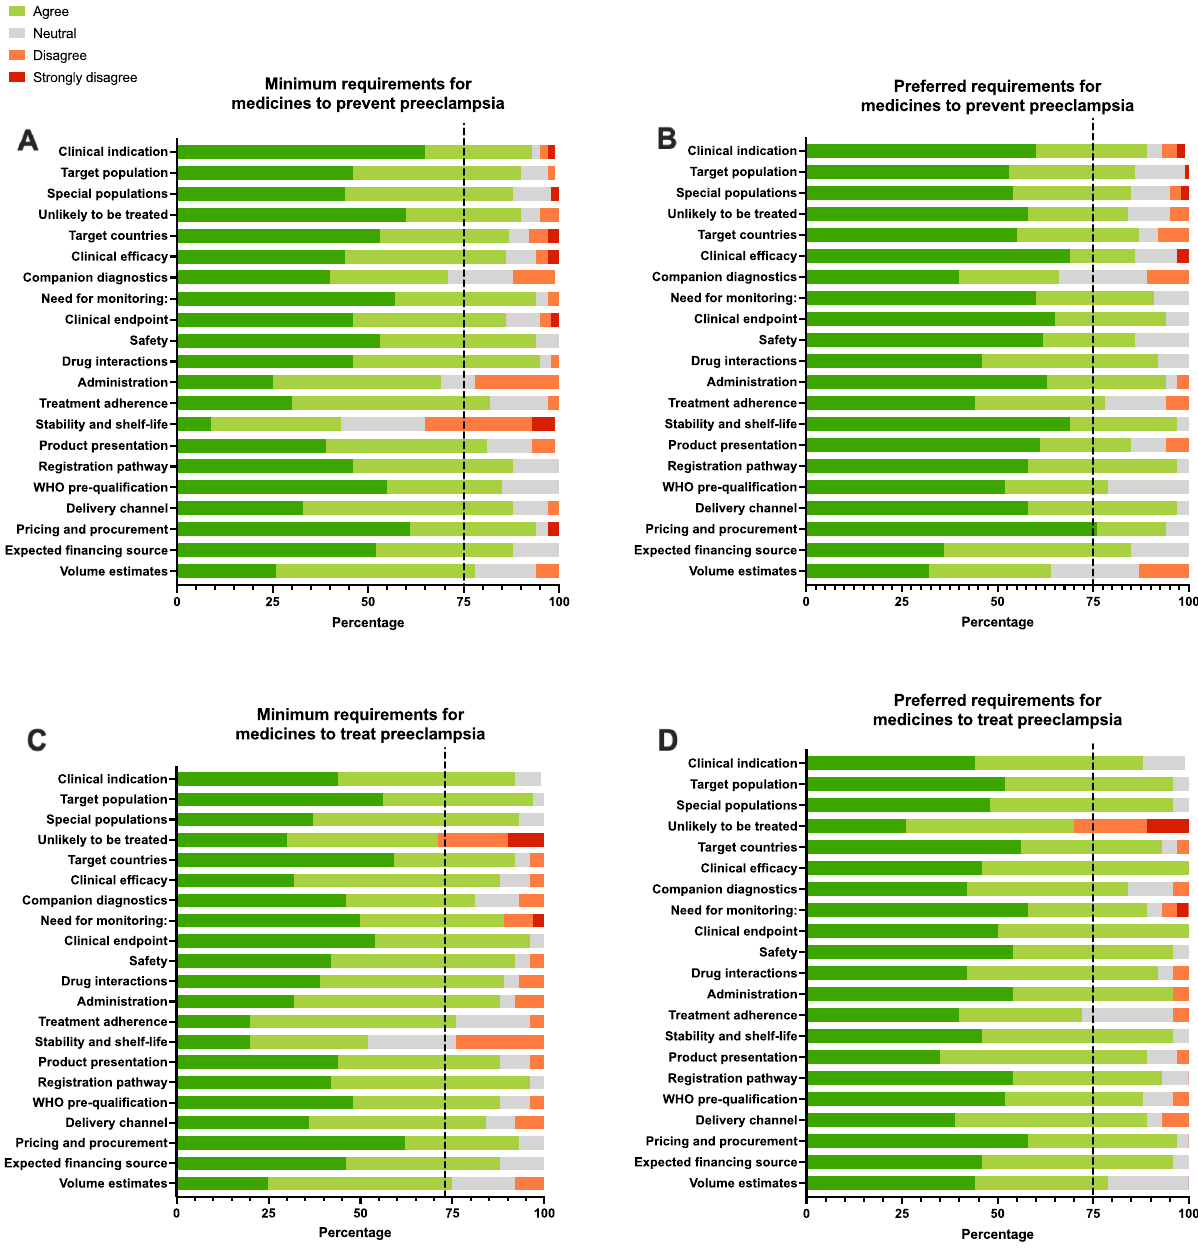
Fig 2. Survey responses. Results from international stakeholder survey (n = 46). Percentage of respondents that strongly agreed (dark green), agreed (light green), were neutral (grey), disagreed (orange) or strongly disagreed (red) in response to the minimum and preferred variable in the TPPs for new medicines to prevent (A = minimum criteria, B = preferred criteria) and treat (C = minimum criteria, D = preferred criteria) preeclampsia. Consensus was considered agreement greater than 75% (black dotted line).